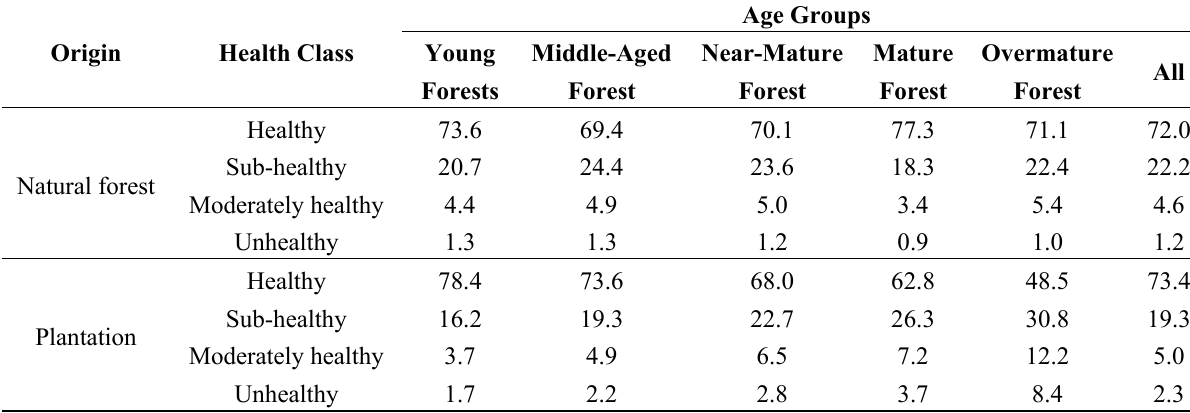
Table 7. Percentages of forests in different health classes by origins and age groups in 2009.